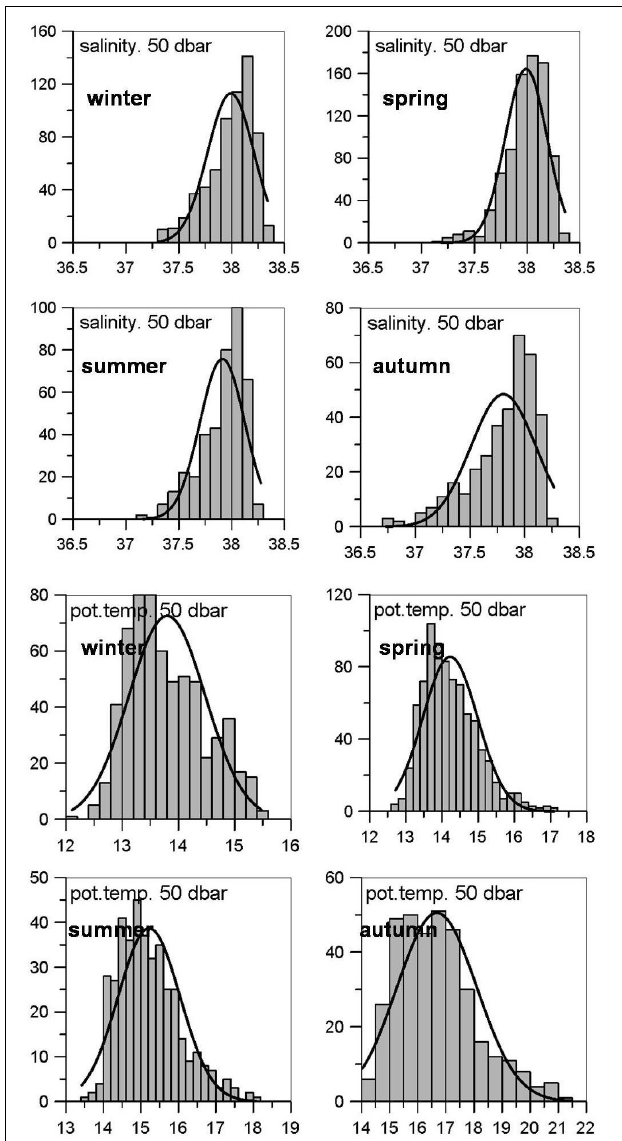
FIGURE 2 | Histograms showing the salinity and potential temperature distribution for the four seasons of the year at the 50 dbar pressure level. A normal distribution was fitted to each distribution (solid